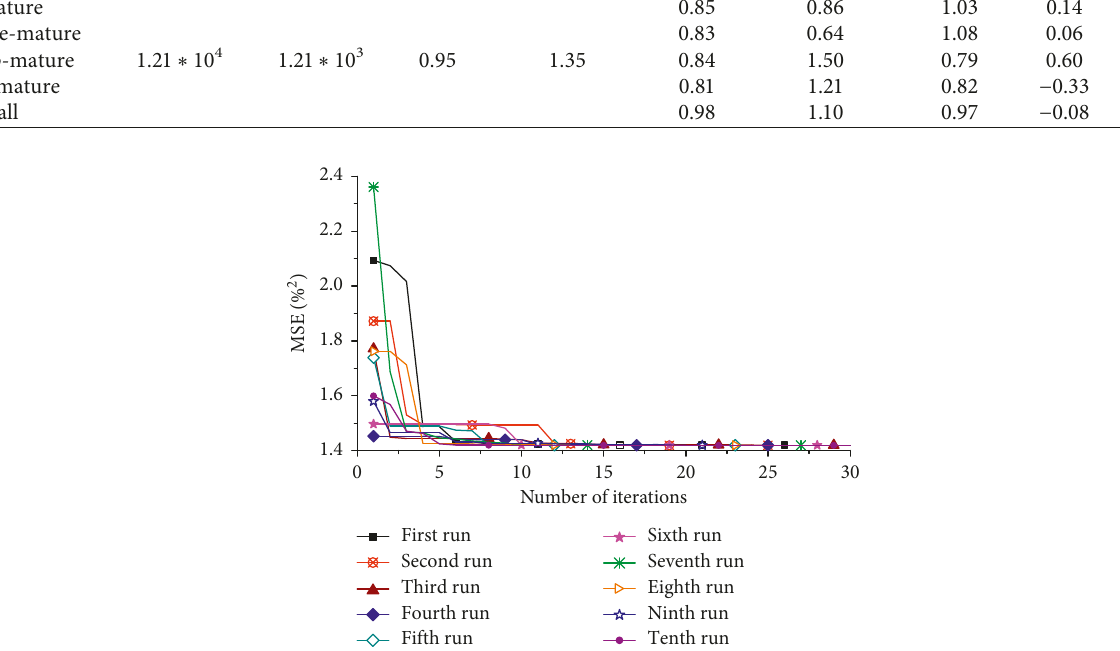
Figure 3: Changing trend of the MSE in the ABC-LS-SVM model searching for optimal parameters. Table 3: Results of GS-LS-SVM and ABC-LS-SVM models for the prediction of SSC using important wavelengths. Modeling algorithms